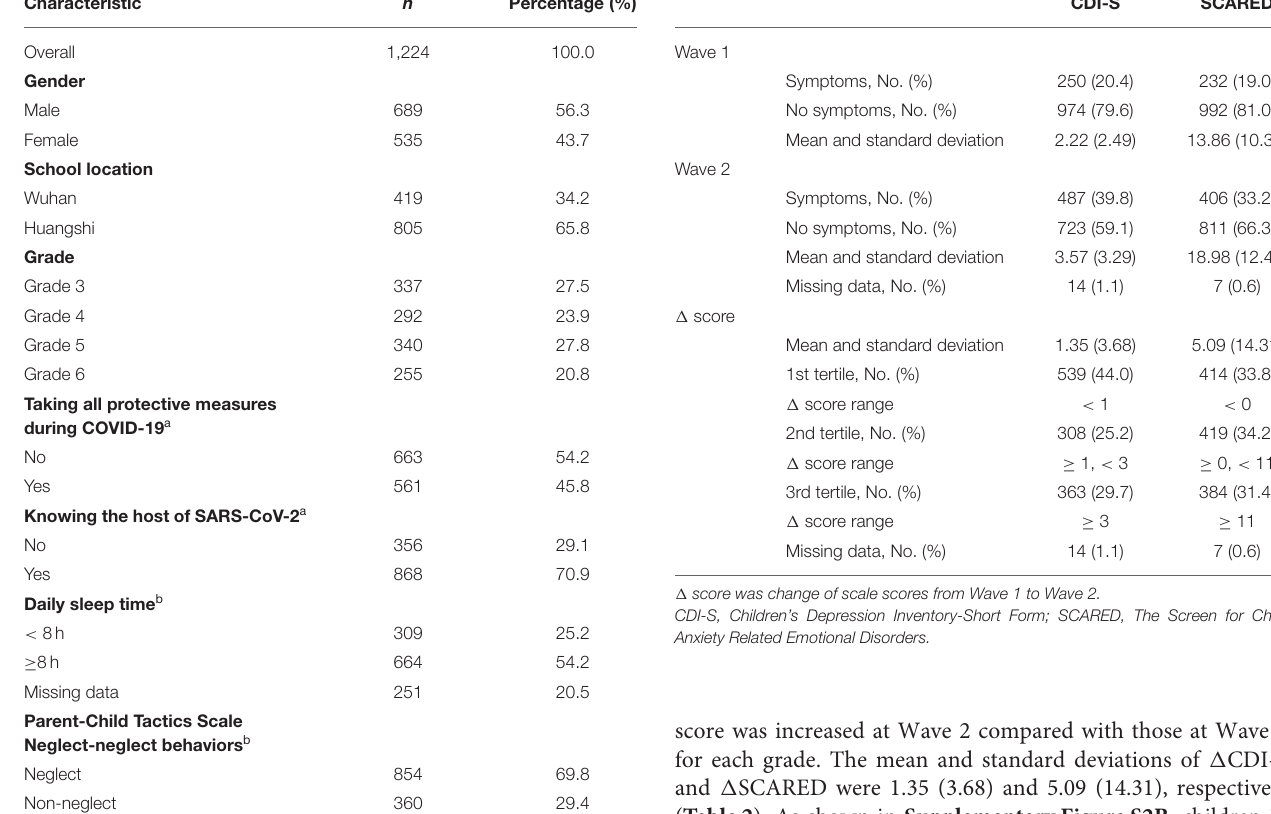
( Table 2 ). As shown in Supplementary Figure S2B , children